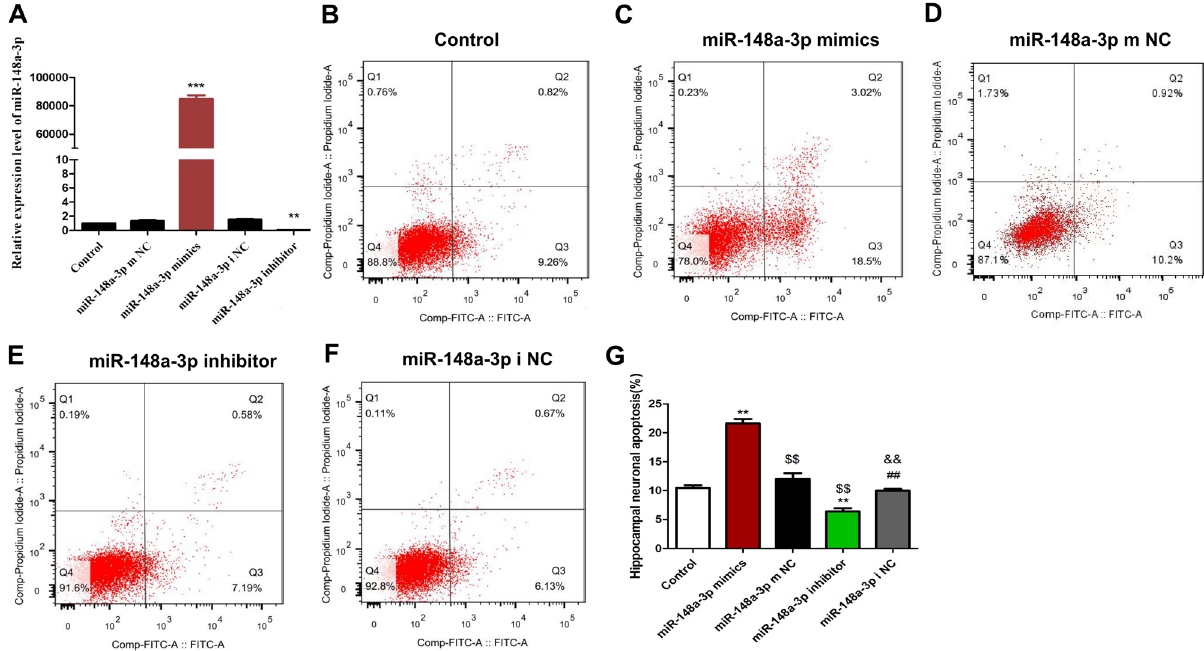
Figure 7. Inhibition of miR-148a-3p reduces hippocampal neuronal apoptosis by kainic acid. ( A ) Relative miR- 148a-3p levels after different treatments. ( B – F ) Cell apoptosis detection by flow cytometry. ( G ) Apoptosis rates of hippocampal neurons. Data are shown as the Mean ± S.E.M. and represent three independent experiments. **P < 0.01 vs. control group; $$,## P < 0.01 vs. miR-148a-3p mimics group; && P < 0.01 vs. miR-148a-3p inhibitor